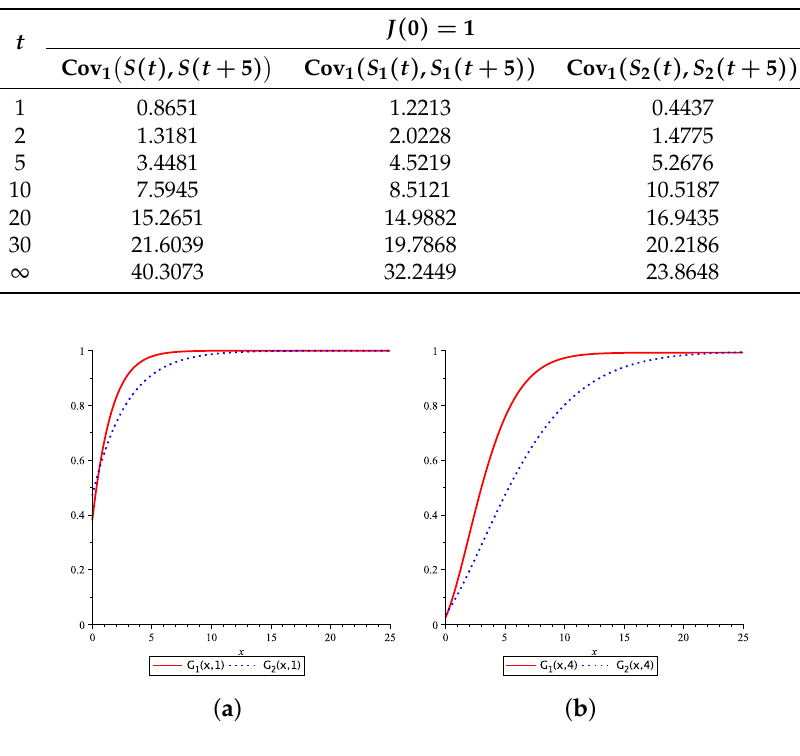
Figure 2. Distribution functions of S ( 1 ) in ( a ) and S ( 4 ) in ( b ) for J ( 0 ) =